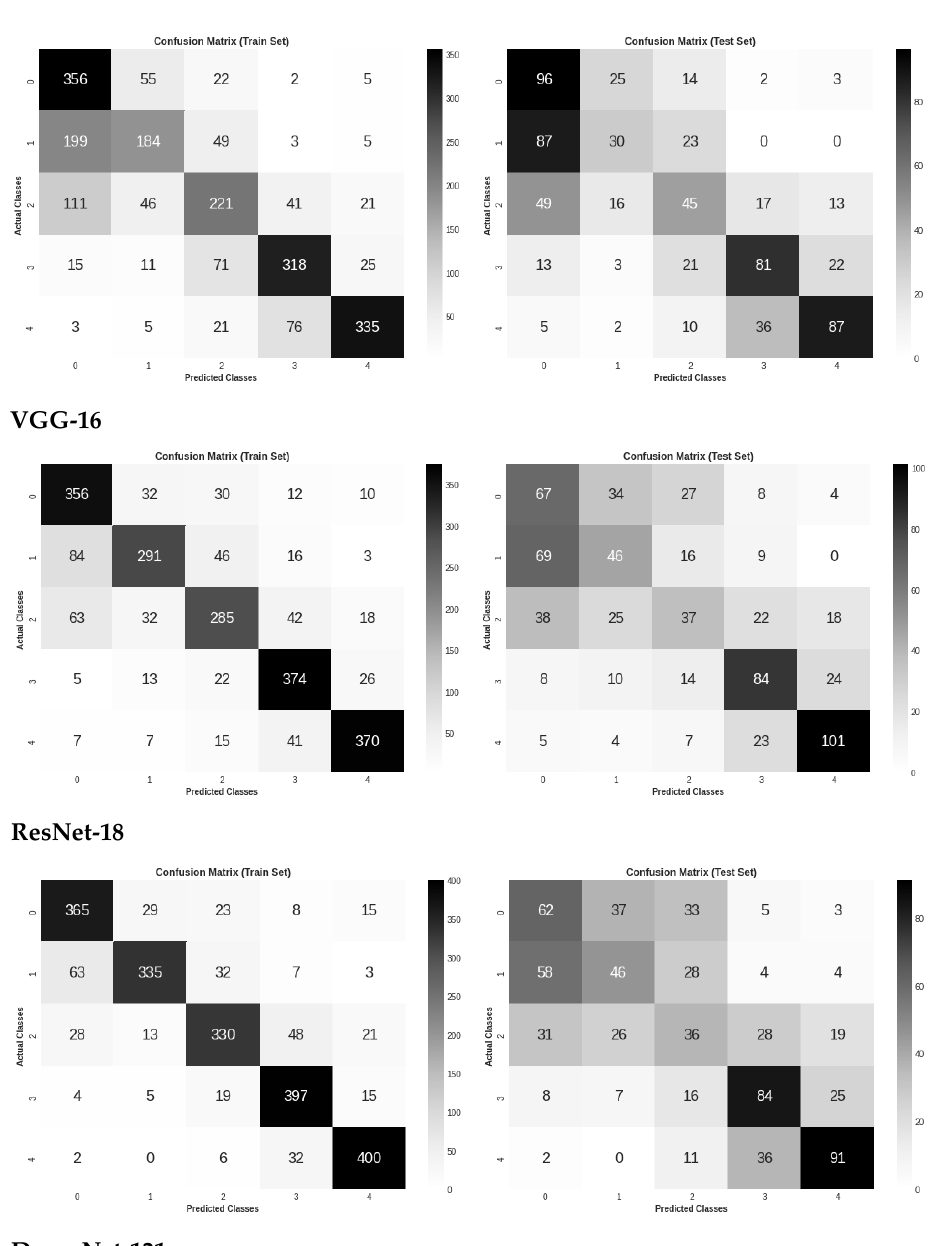
Figure 6. Confusion matrix evaluation of the three models on the test and train sets for five classes classification.